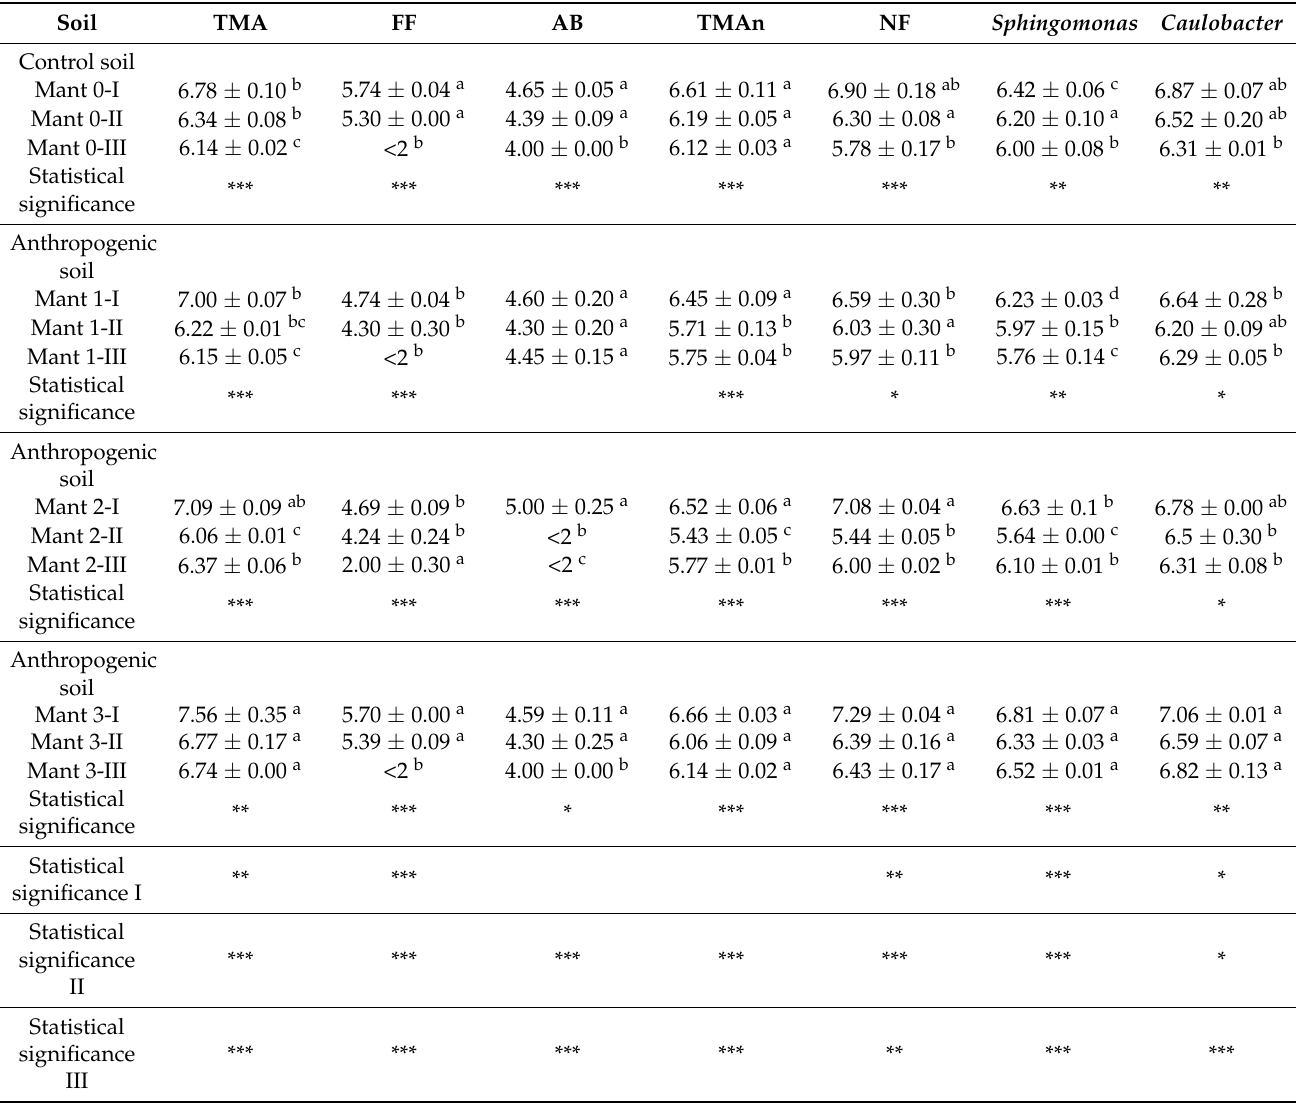
Table 2. Results of plate count agar of the microbial